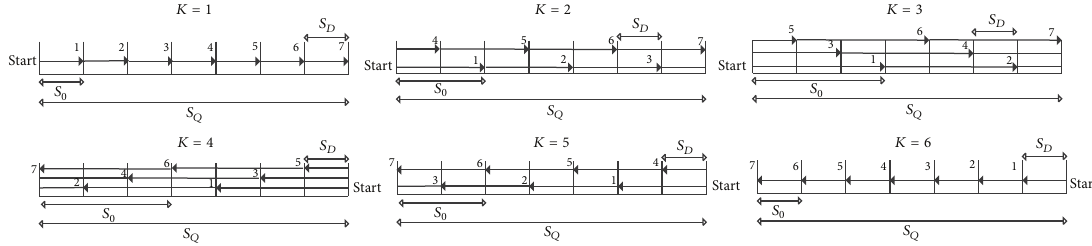
Figure 1: Ground track sequences for 𝐷 = 7 .